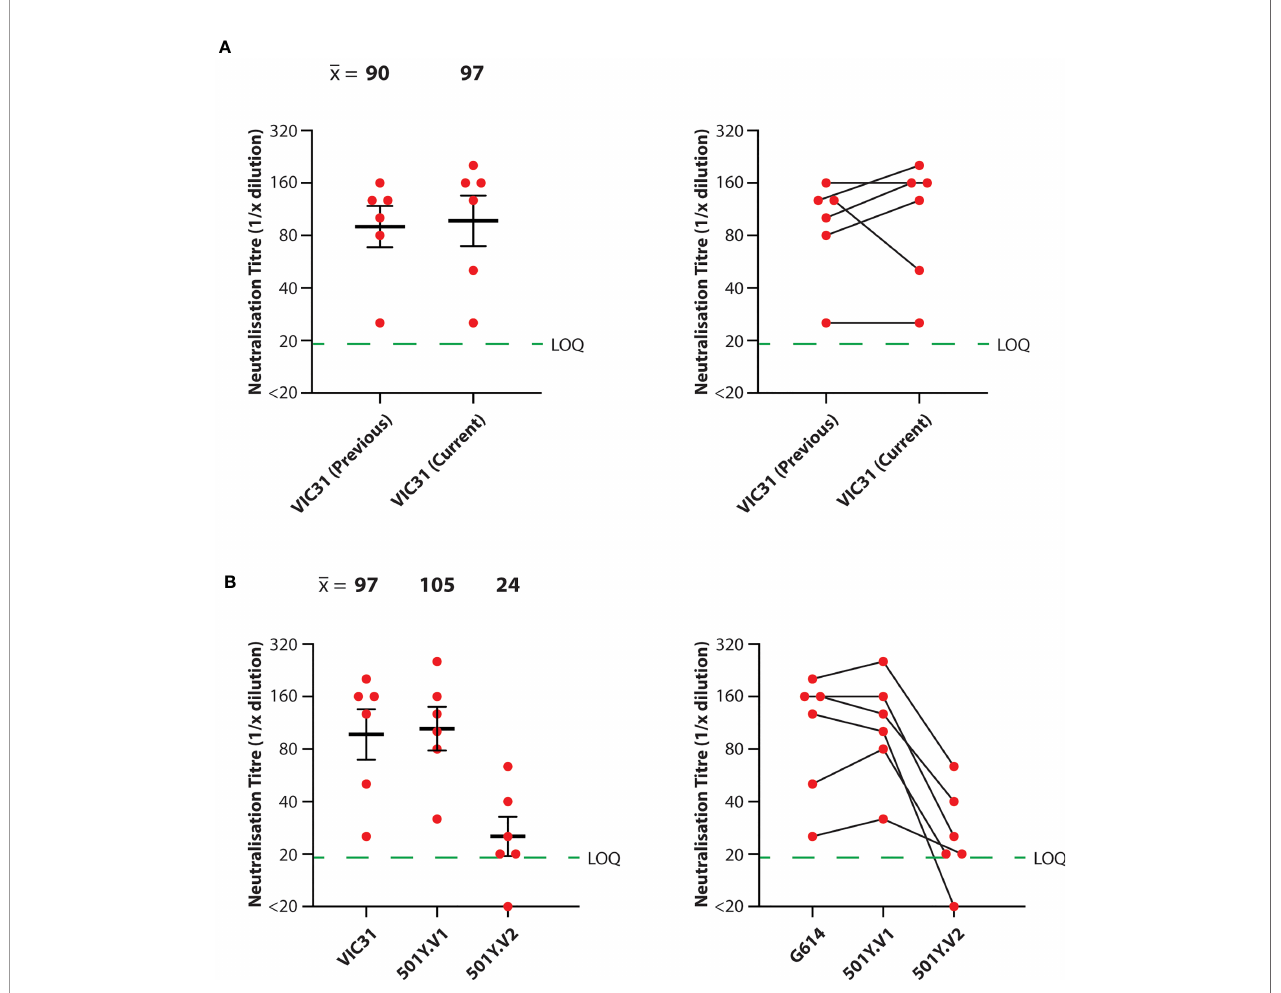
FIGURE 1 | Neutralisation of SARS-CoV-2 Variants-of-Concern with Serum from INO-4800-Vaccinated Ferrets. Neutralisation titres were obtained in triplicate for serum samples collected from ferrets receiving prime and boost doses of INO-4800. (A) Comparison of anti-VIC31 (G614 variant) titres from the current and previous studies (9) demonstrating inter-assay reproducibility (left; p>0.05 by paired, two-tailed t-test), and tracking of values from individual animals (right). (B) Comparison of neutralisation titres against VIC31 (G614 variant), 501Y.V1 and 501Y.V2 variants (left; p<0.001 by mixed effects ANOVA), and tracking of values from individual animals (right). Horizonal lines represent geometric mean and geometric standard error of the mean. The green dashed line represents the lowest quanti fi able titre (LOQ, Limit of Quanti